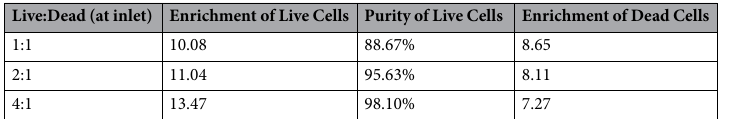
Table 2. Enrichment of live and dead cells at different ratios of cells at the